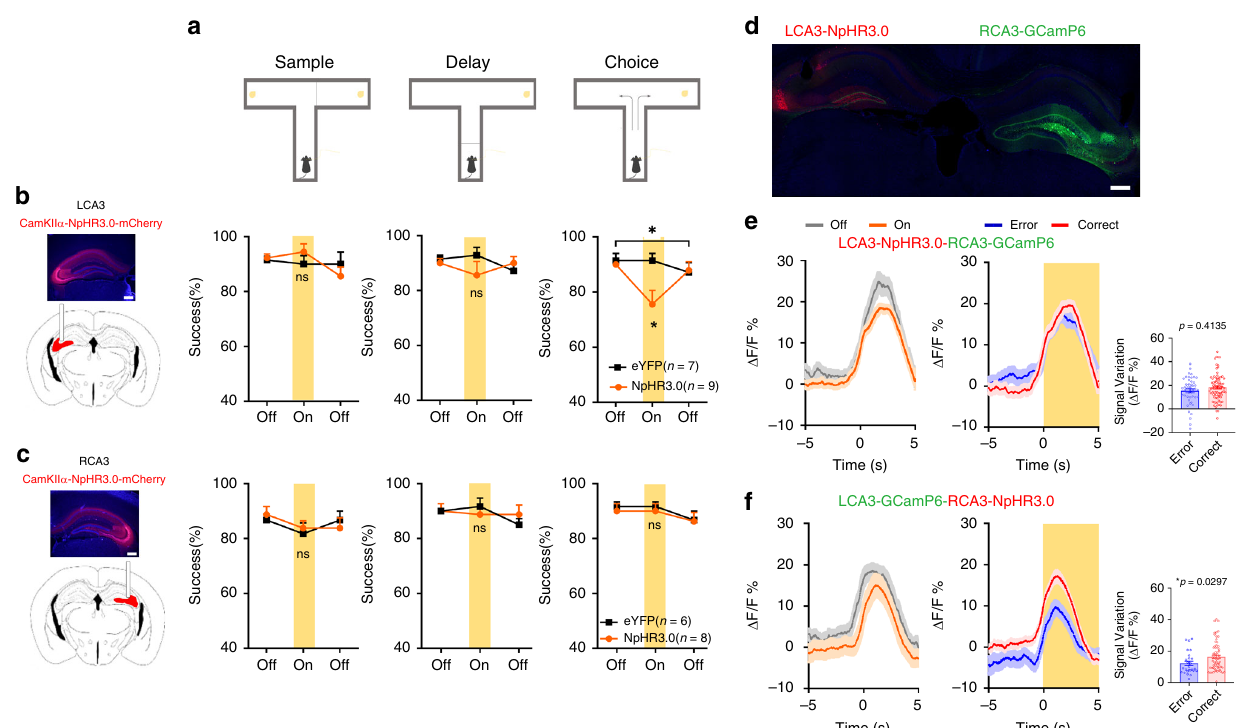
Fig. 3 Inhibition of LCA3 impairs the SWM in T-maze task. a Schematic of tDNMTP task. b , c Left: viral injection and optic fi ber implantation for inhibiting LCA3 neurons ( b ) or RCA3 neurons ( c ). Scale bar: 200 μ m. Right: the percentage of correct performance in mice receiving LCA3 ( n = 7 mCherry, n = 9 NpHR3.0) or RCA3 illumination ( n = 6 mCherry, n = 8 NpHR3.0) during the sample phase (a two-way repeated measures ANOVA (rmANOVA), light vs group, LCA3, P = 0.3476; RCA3, P = 0.52), during the last 5 s of the delay phase (rmANOVA, light vs group, LCA3, P = 0.21; RCA3, P = 0.54), and during the choice phase (rmANOVA, light vs group, LCA3, * P = 0.0295; RCA3, P = 0.97). d Representative confocal images of NpHR3.0 expression in the LCA3 and GCamp6s expression in the RCA3 (blue, DAPI; green, GCamp6s; red, mCherry). Scale bar: 200 μ m. e Left: the mean and SEM of Ca 2 + signal in RCA3 neurons during LCA3 photo-inhibition in the choice phases from fi ve mice. Middle: the mean and SEM of Ca 2 + signal in RCA3 neurons in choice phase between the correct and error trials during LCA3 pyramidal neurons inhibition. Right: quanti fi cation of the average amplitude of increased signal against baseline between the correct and error trials in RCA3 at the choice phase (error: n = 26 trials; correct: n = 65 trials; unpaired two-tailed Mann – Whitney-U- test, P = 0.4135). f Left: the mean and SEM of Ca 2 + signal in LCA3 neurons during inhibition of RCA3 neurons in the choice phases from fi ve mice. Middle: the mean and SEM of Ca 2 + signal in LCA3 neurons at the choice phase between the correct and error trials during RCA3 pyramidal neurons inhibition. Right: quanti fi cation of the average amplitude of increased signals against baseline between the correct and error trials in LCA3 at the choice phase (error: n = 26 trials; correct: n = 65 trials; unpaired two-tailed Mann – Whitney-U-test, * P = 0.0297). Data are presented as mean + SEM ( b , c right panels) and mean ± SEM ( e , f right panels). Source data are provided as a Source Data fi